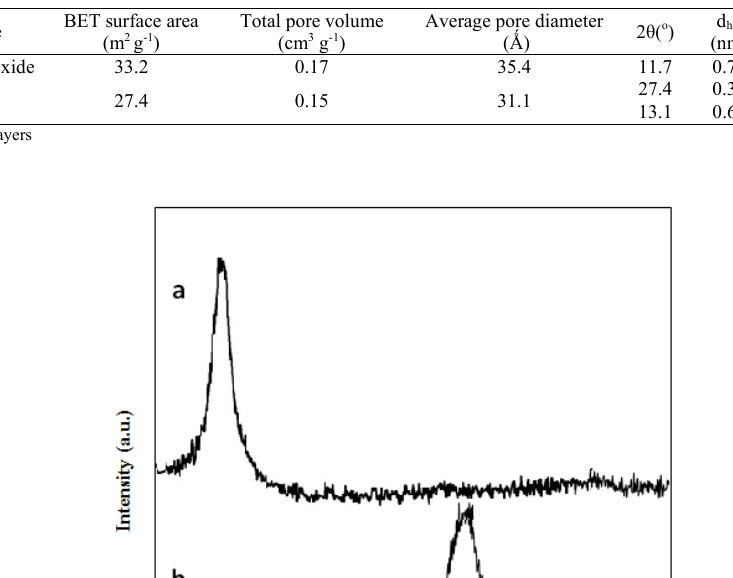
Table 1. XRD results and textural properties of the prepared samples.